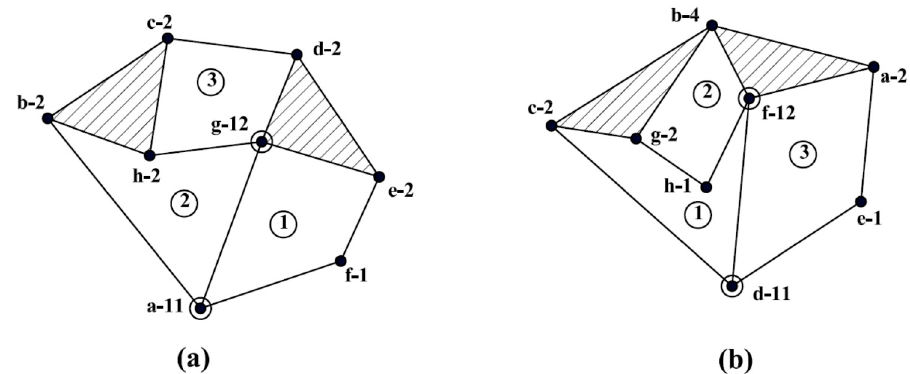
Figure 10. Unified chain matrix for the kinematic chain in Figure 9a,b.